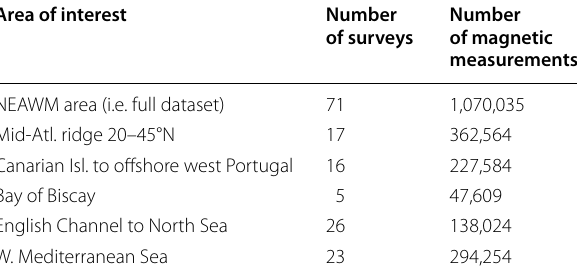
Table 2 Number of surveys and magnetic measurements (after filtering and sub-sampling) used in the study Area of